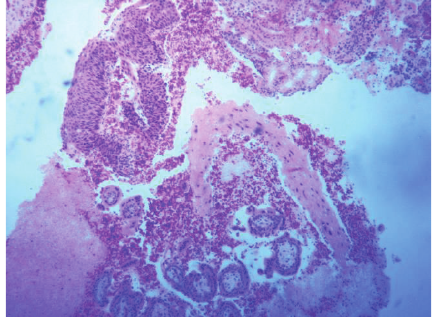
Figure 1: Products of conception with CIN II.